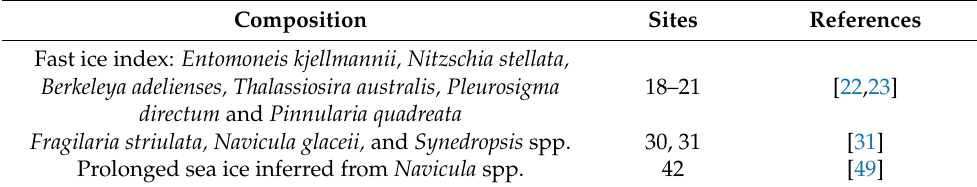
Table 6. Composition of proxy groups excluding Fragilariopsis curta